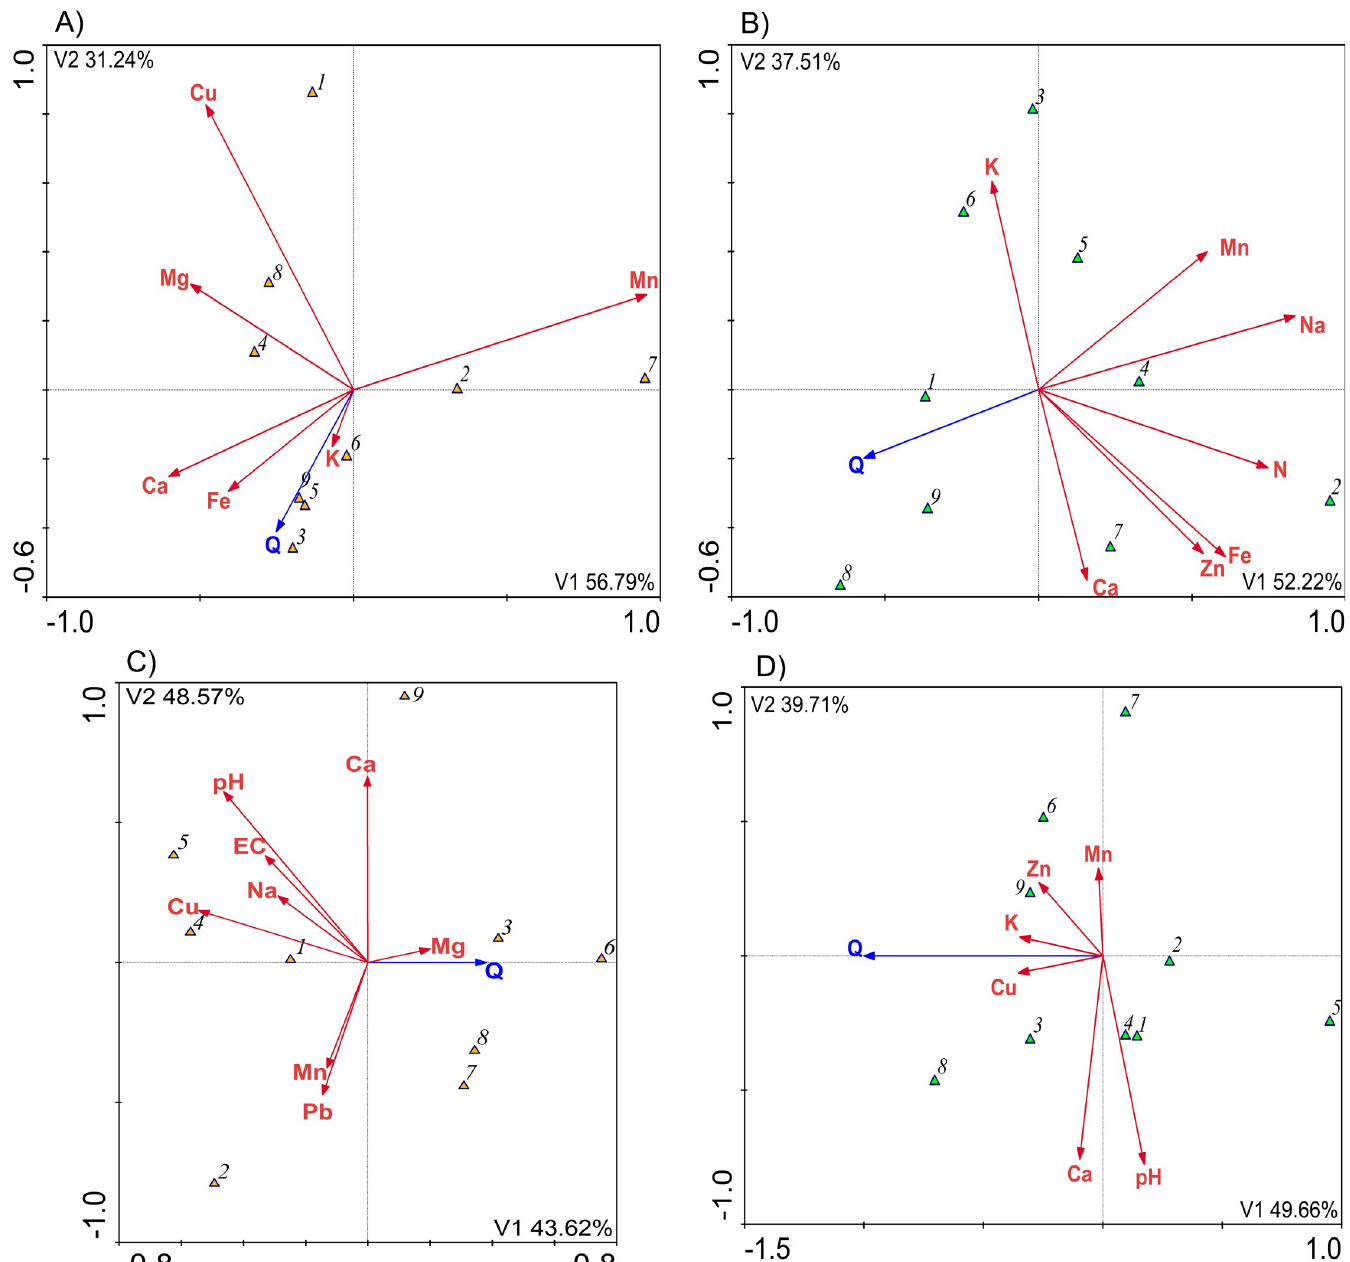
Fig 2. A CCA model. The dependencies between the parameters in the leaves of: A) lime-trees, B) horse chestnut trees; and in the soil at the sites of: C) lime-trees, D) horse chestnut trees and the health of the trees (Q) at their locations (items numbered as in Table